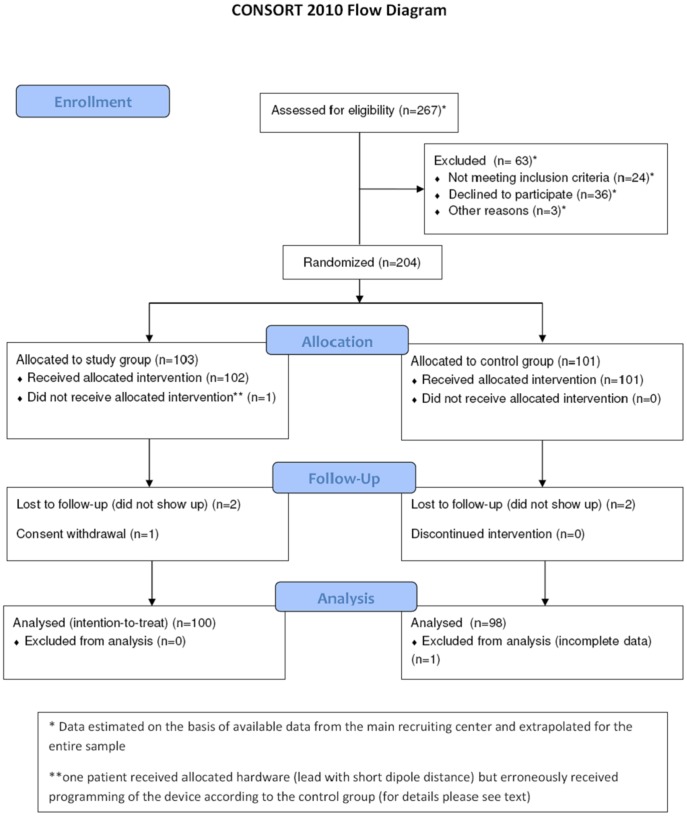
Study flow-chart.